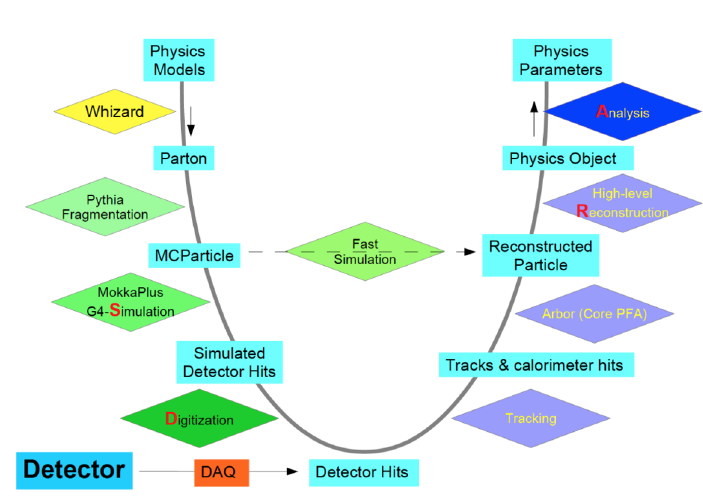
Figure 4 . The information flow of the CEPC software chain